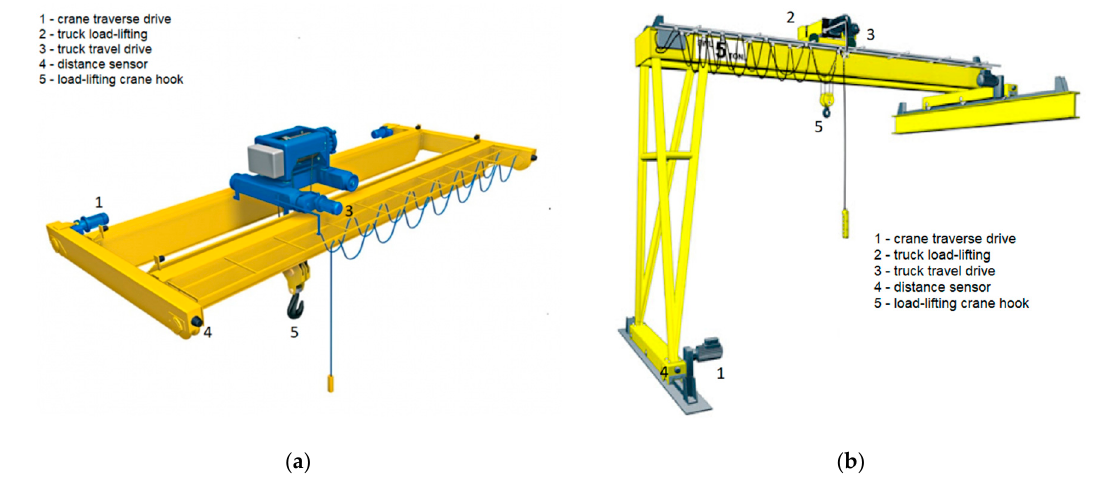
Figure 7. Traveling and semigantry cranes: ( a ) a traveling crane; ( b ) a semigantry crane.